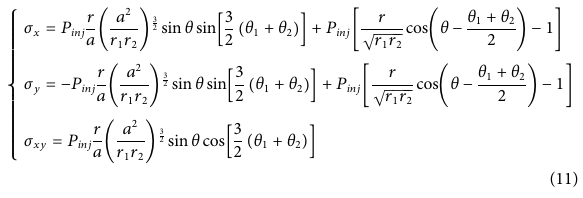
Frontiers in Earth